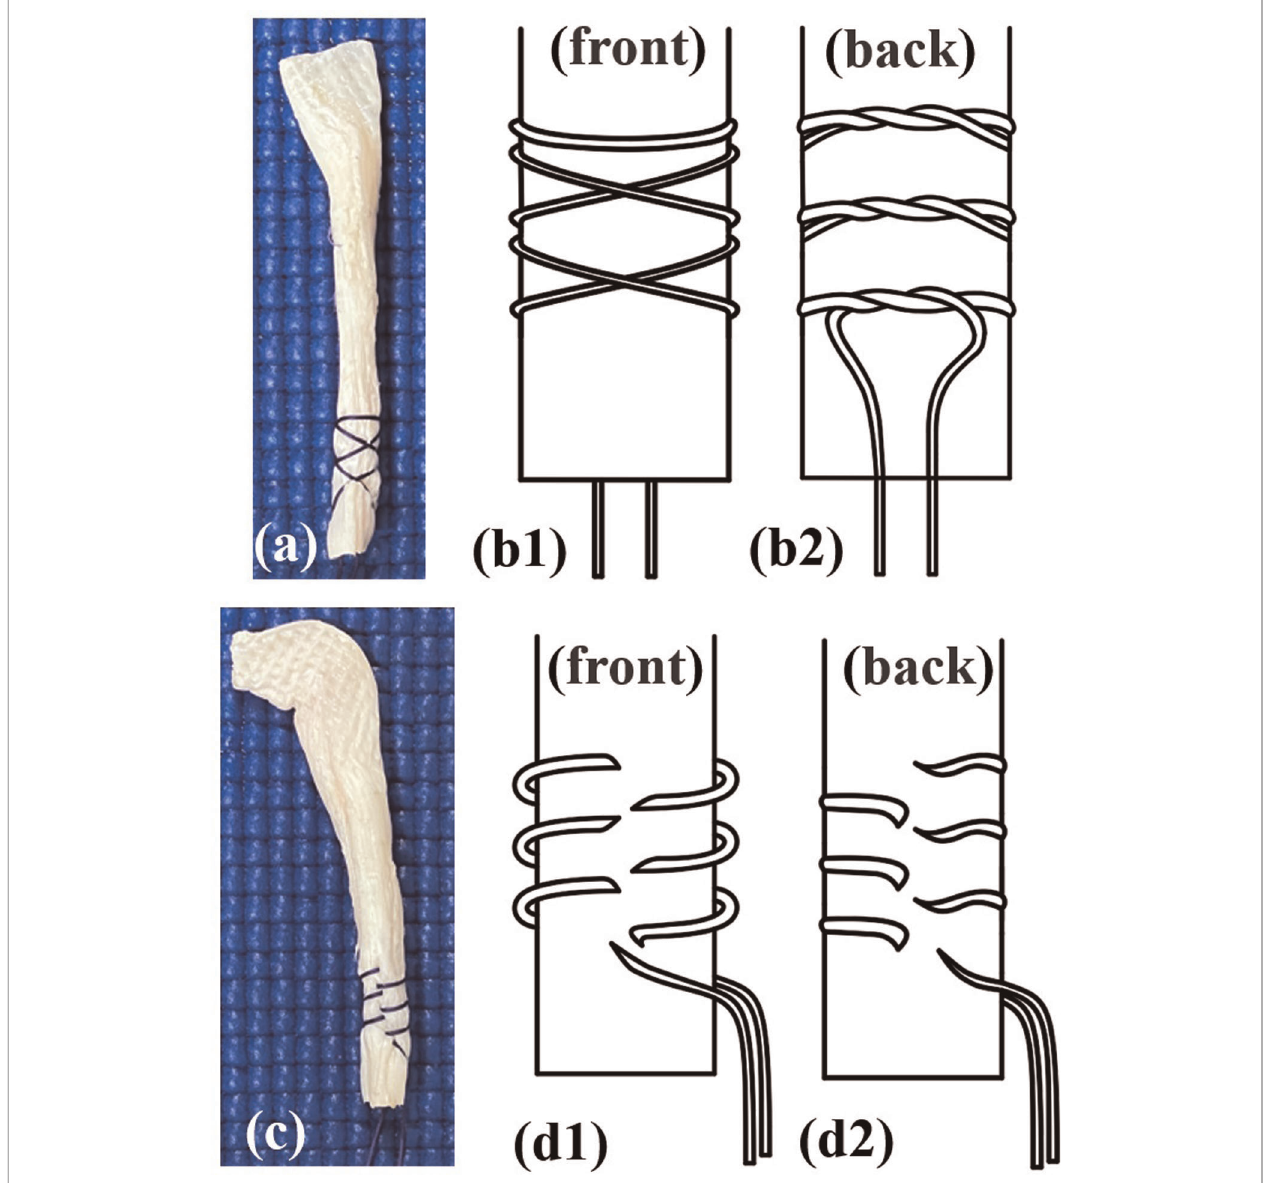
FIGURE 1 | Two suture techniques are investigated: a photograph ( A ) and diagram ( B1 , B2 ) of the needleless grasping suture technique group, and a photograph ( C ) and diagram ( D1 , D2 ) of the needle stitching technique group. The needleless grasping suture technique group is started by wrapping the suture around the porcine fl exor tendon, and the working end of the suture is then crossed over the other end of the suture. The graft preparation is completed with a hitch by making a turn around the porcine fl exor